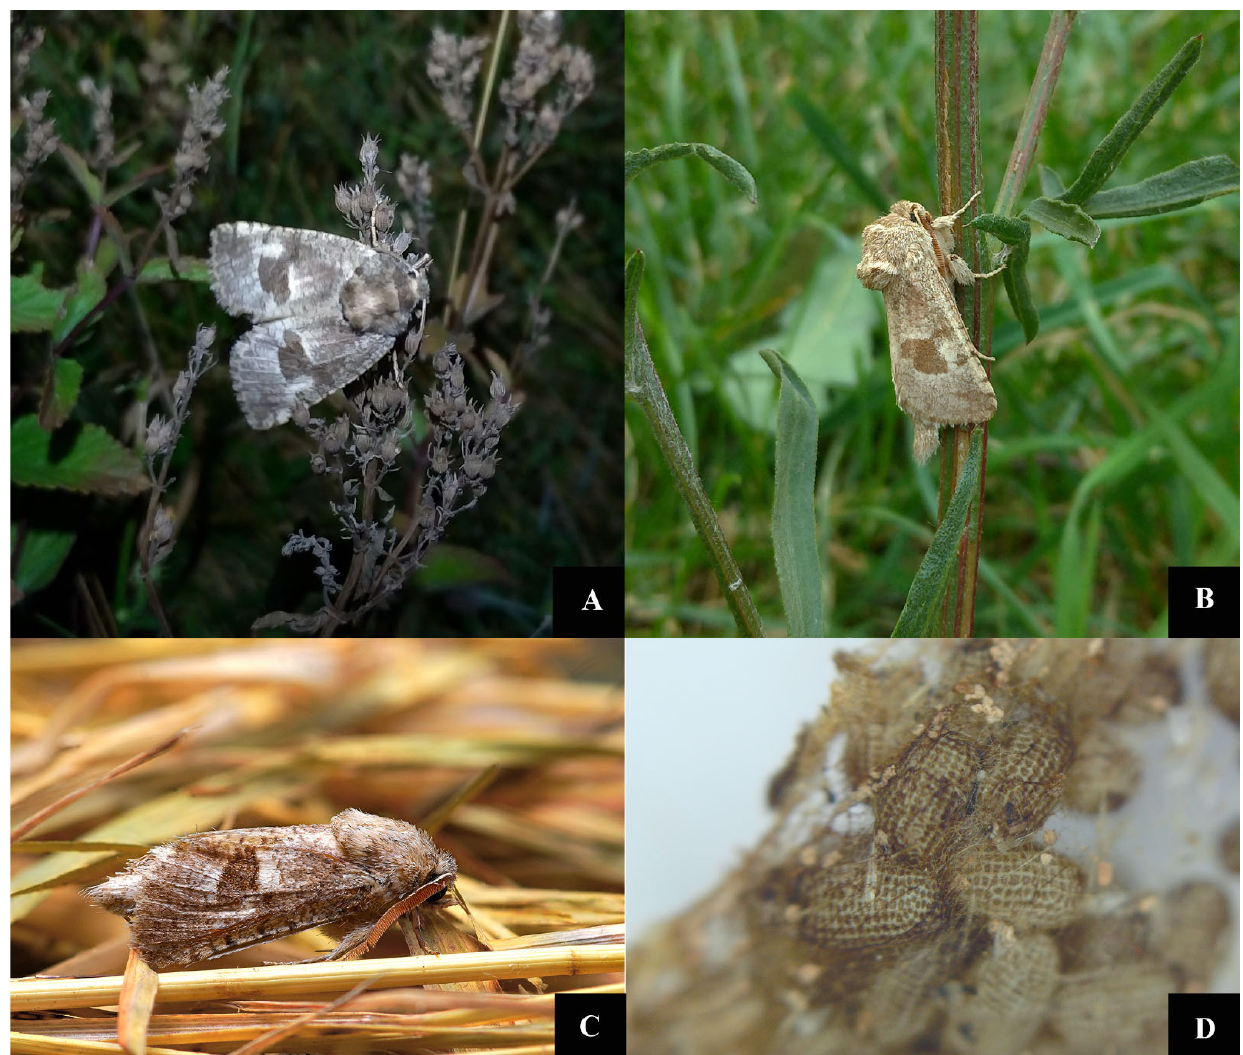
Figure 2. Paracossulus thrips —imago ( A ) Female collected from ROSCI0210 Râpa Lechin ț a on 14 August 2021. ( B ) Male collected from ROSCI0238 Suatu–Cojocna–Crairât near Plosco ș (Valea Florilor) on 7 July 2015. ( C ) Male collected from ROSCI0272 Vulcanii Noroio ș i on 5 August 2015. ( D ) P. thrips eggs—photo under stereomicroscope.